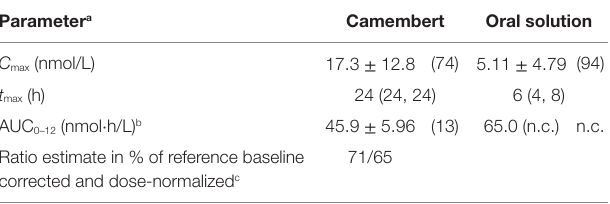
TaBle 2 | summary table of baseline corrected 5-ch 3 -h 4 folate biokinetic parameter in plasma.